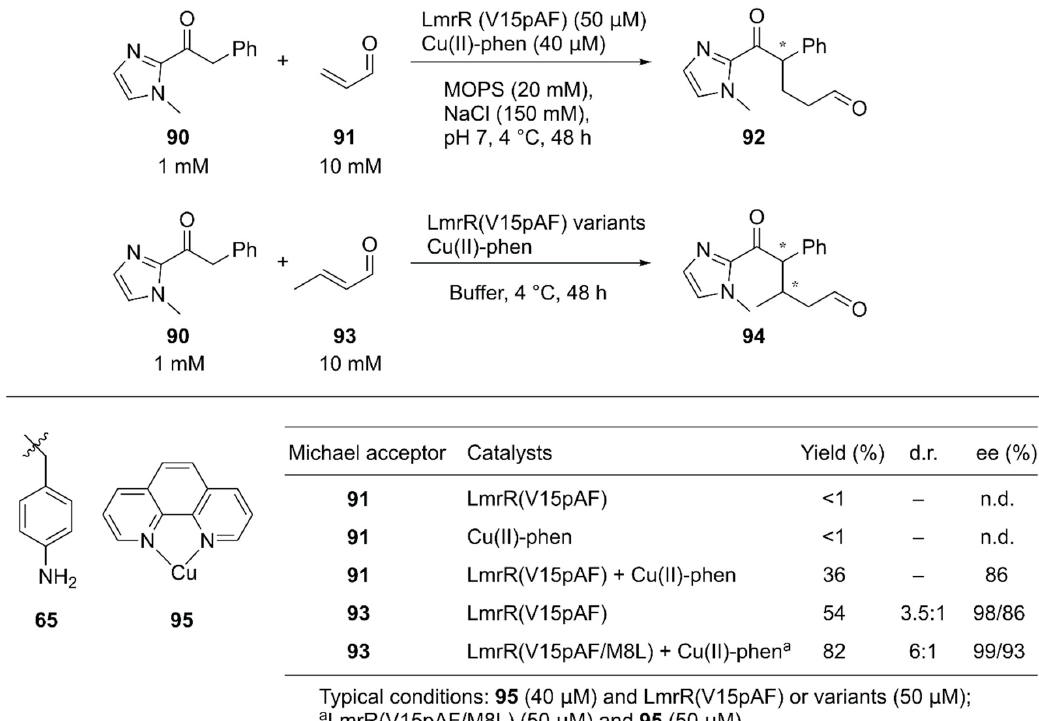
Figure 18. Synergistic catalysis by the unnatural amino acid 65 and Cu complex 95 in a LmrR-based artificial enzyme. Adapted from [94]. See Figure 13 for the crystal structure of LmrR (V15pAF).